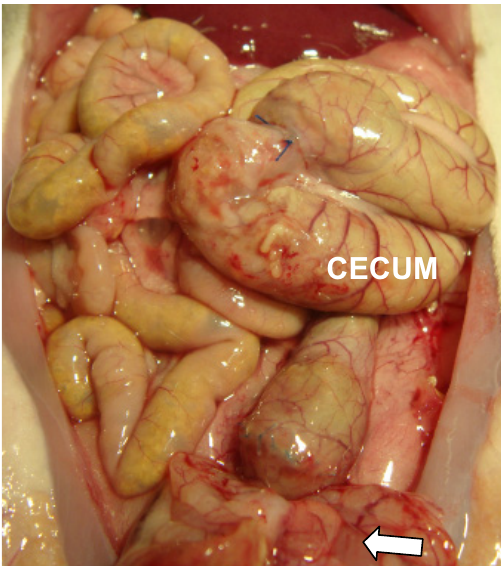
FIGURE 3 – Aspect of the abdominal cavity of animal in the HCG: presence of great quantity of free liquid in the cavity, distension of the tenuous bowels laps and cecum, purulent collections spread. Full